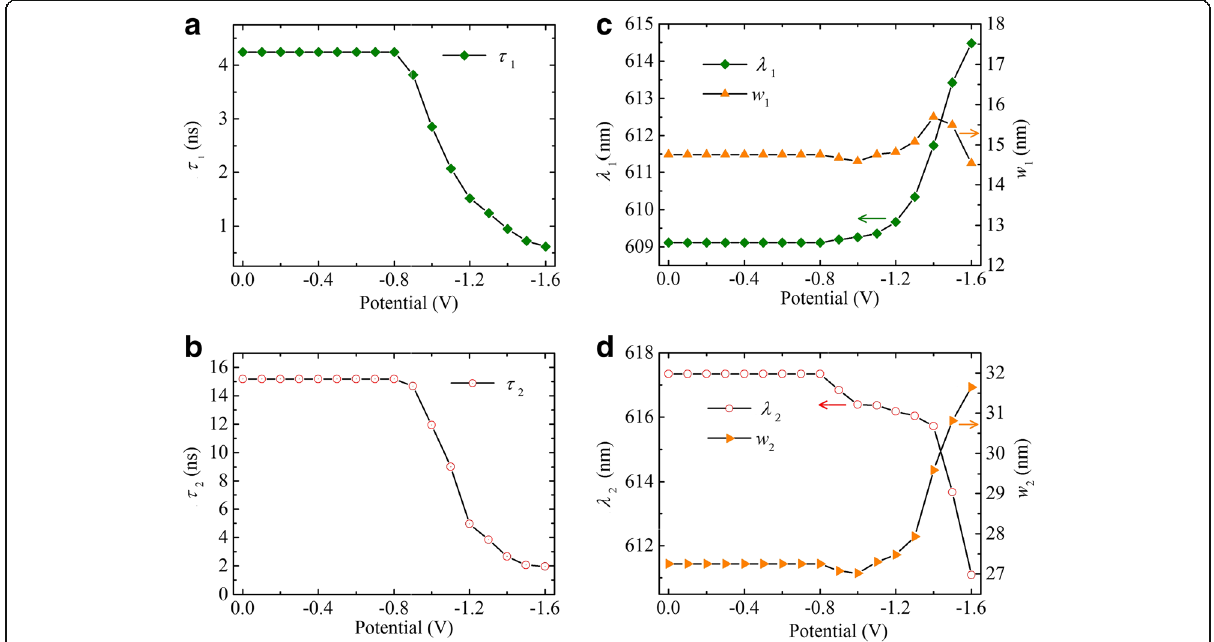
Fig. 4 Electrochemical potential dependent fitting parameters of core emission ( a , c ) and surface emission ( b , d ). The decay times of both the emitting states decrease at an applied potential of − 0.9 V. The core emission shows a redshift ( c , green squares), and the surface emission shows a blueshift ( d , red circles). Orange triangles represent the FWHM of the two emission